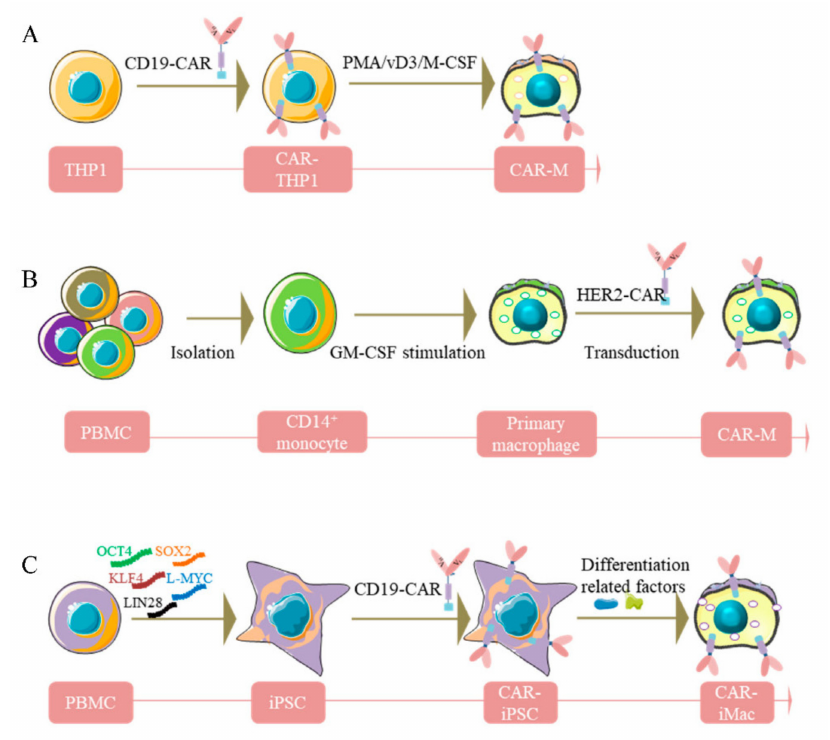
Figure 1. Diagram of the generation of CAR-macrophages. ( A ), Human THP-1 cells were engineered with CAR and then differentiated into CAR-macrophages. ( B ), Primary human macrophages were generated from peripheral blood CD14 + monocytes with GM-CSF and transduced to express CAR. ( C ), iPSCs were reprogrammed from PBMC, then differentiated into